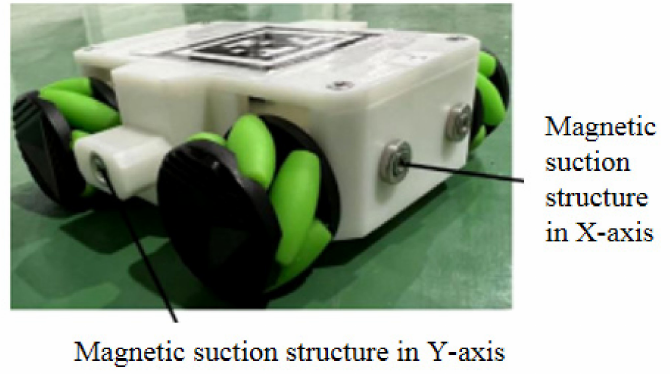
Figure 8. Magnetic suction